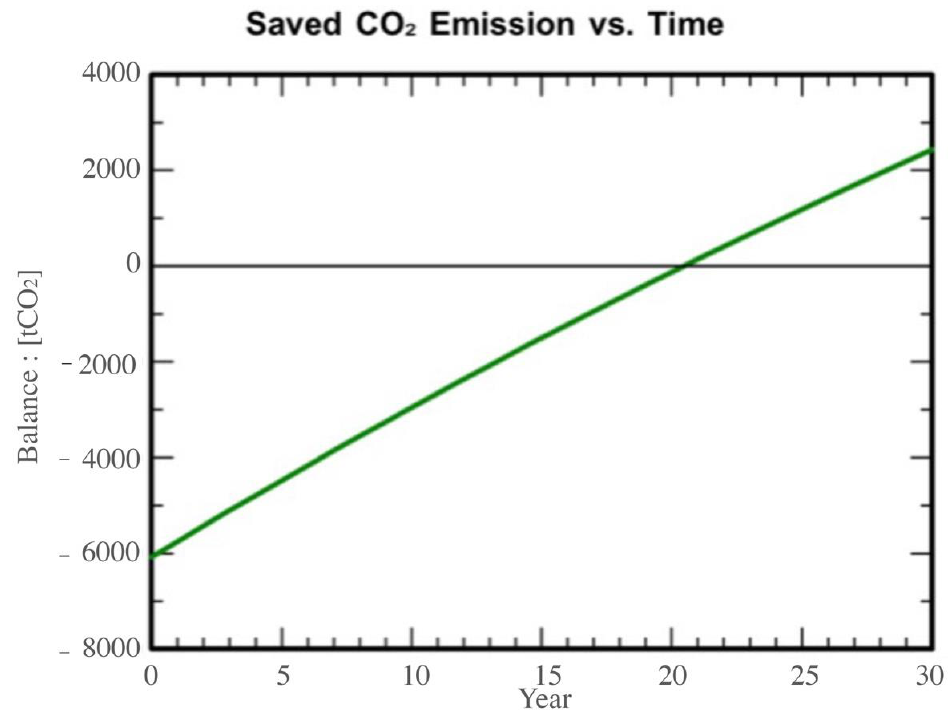
Figure 6. CO 2 emission reduction vs.